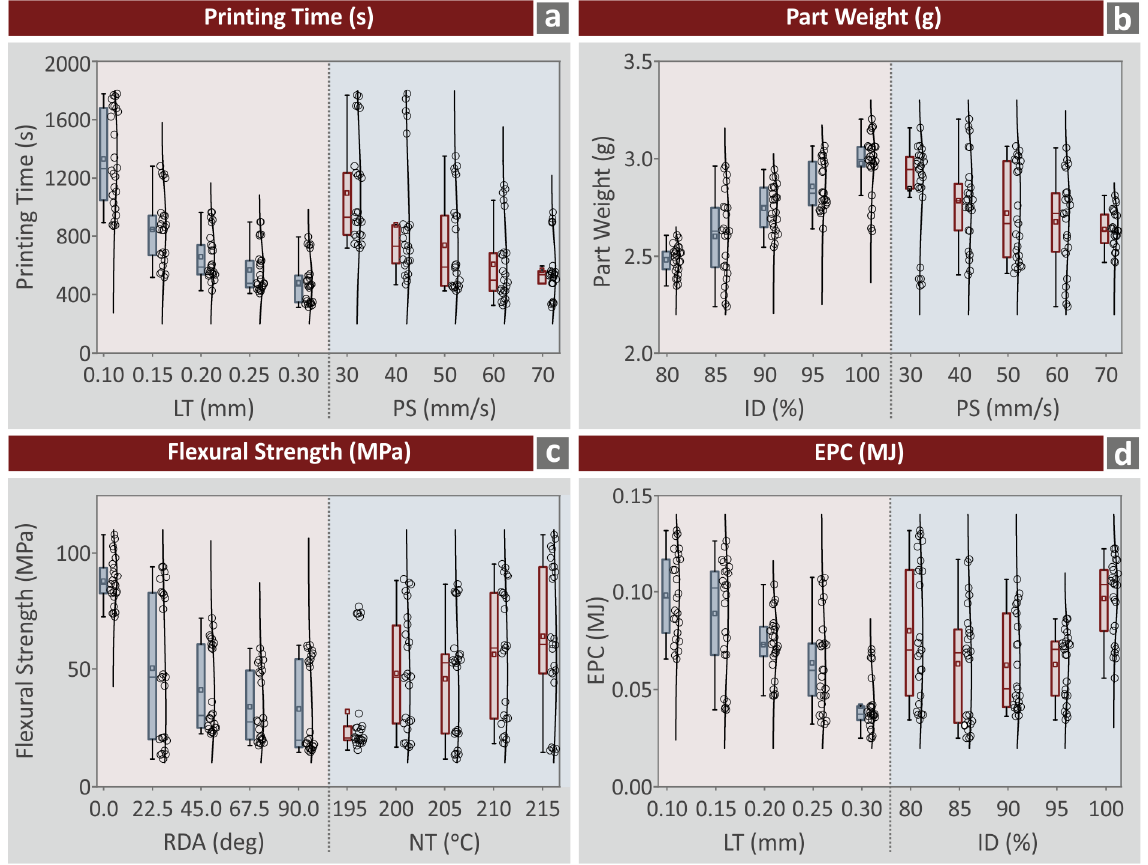
Figure 6. Box plot diagrams for four of the metrics evaluated herein ( a ) printing time (s), ( b ) part weight (g), ( c ) flexural strength (MPa), ( d ) EPC (MJ). weight (g), ( c ) flexural strength (MPa), ( d ) EPC MEPs indicate the effect of each control parameter level on a specific metric studied.